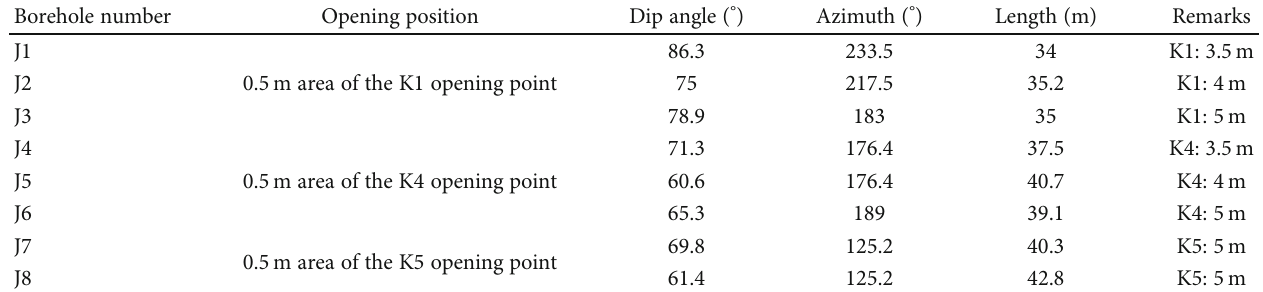
Figure 8: Diagram of the designed project. Table 1: Veri fi cation of hole drilling